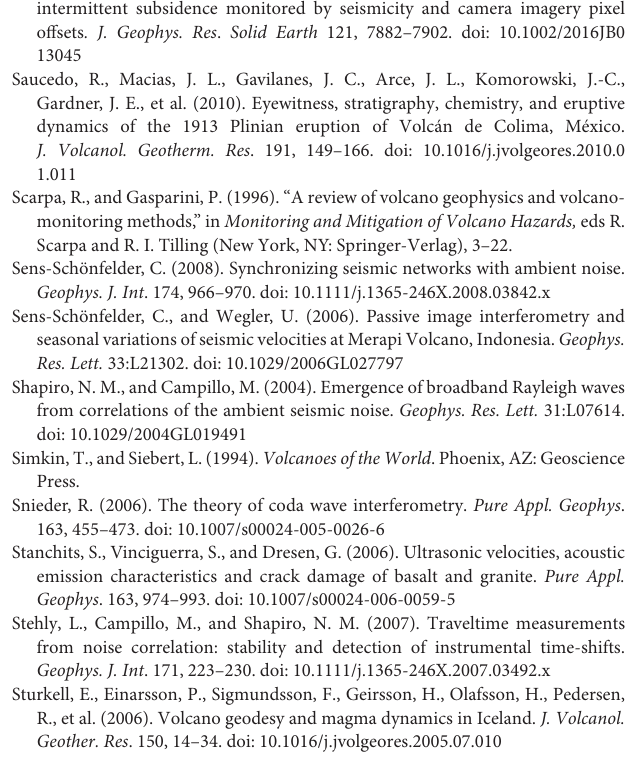
variations in the crust using earthquake doublets: an application to the Calaveras fault, California. J. Geophys. Res. 89, 5719-5731. Quezada-Reyes, A., Lesage, P., Valdés-González, C., and Perrier, L. (2013). An analysis of the seismic activity of Popocatépetl Volcano, Mexico, associated with the eruptive period of december 2002 to february 2003: looking for precursors. Geol. Soc. Lond. 498, 89–106. doi: 10.1130/2013.24 98(06) Ratdomopurbo, A., and Poupinet, G. (1995). Monitoring a temporal change of seismic velocity in a volcano: application to the 1992 eruption of